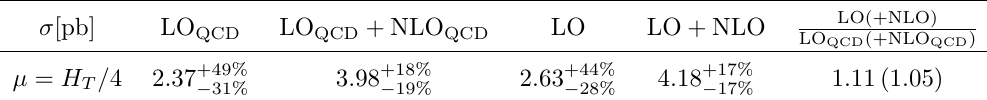
Table 6 . Same as in table 5 but for 100